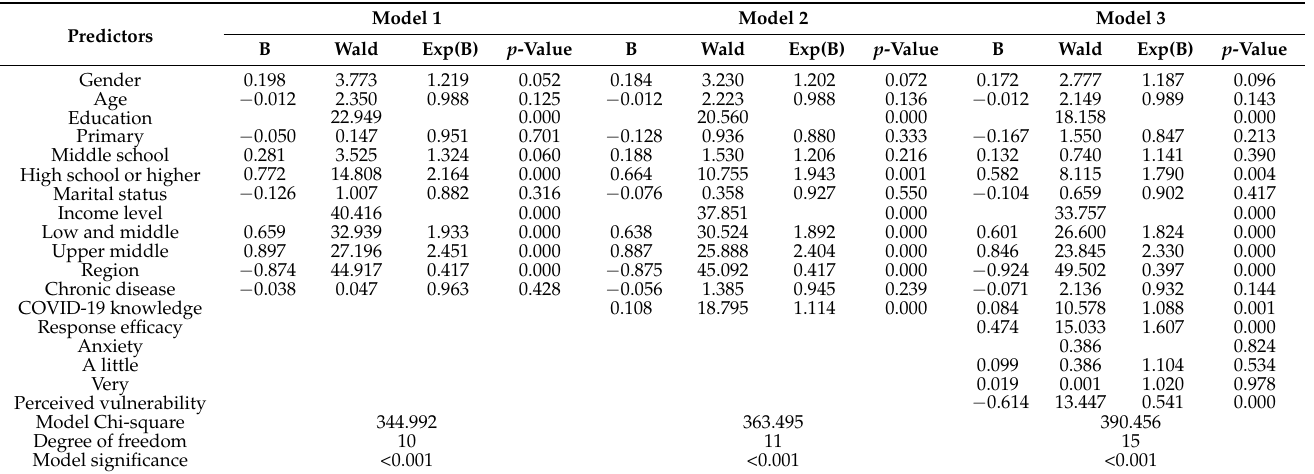
Table 3. Hierarchical logistic regression results on factors related to hand